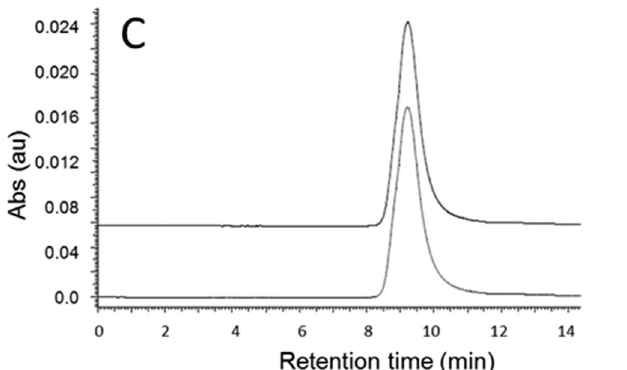
Figure 2. SEC-HPLC analysis of ( A ) PMLA before (lower trace) and after (upper trace) standard ammonolytic treatment at 220 nm wavelength; ( B ) Herceptin before (lower trace) and after (upper trace) standard ammonolytic treatment at 280 nm wavelength; and ( C ) AON before (lower trace) and after (upper trace) standard ammonolytic treatment at 260 nm